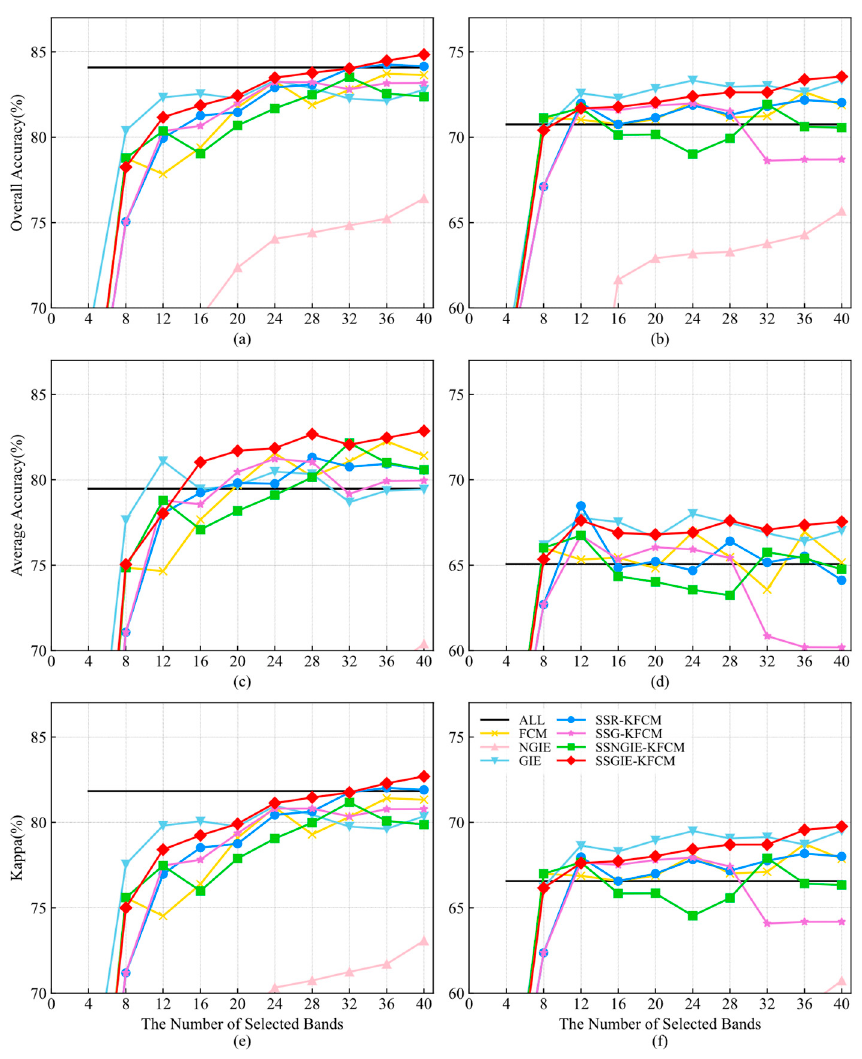
Figure 10. Ablation results using the Indian Pines dataset. ( a , c , e ) are SVM classifiers; ( b , d , f ) are KNN classifiers.